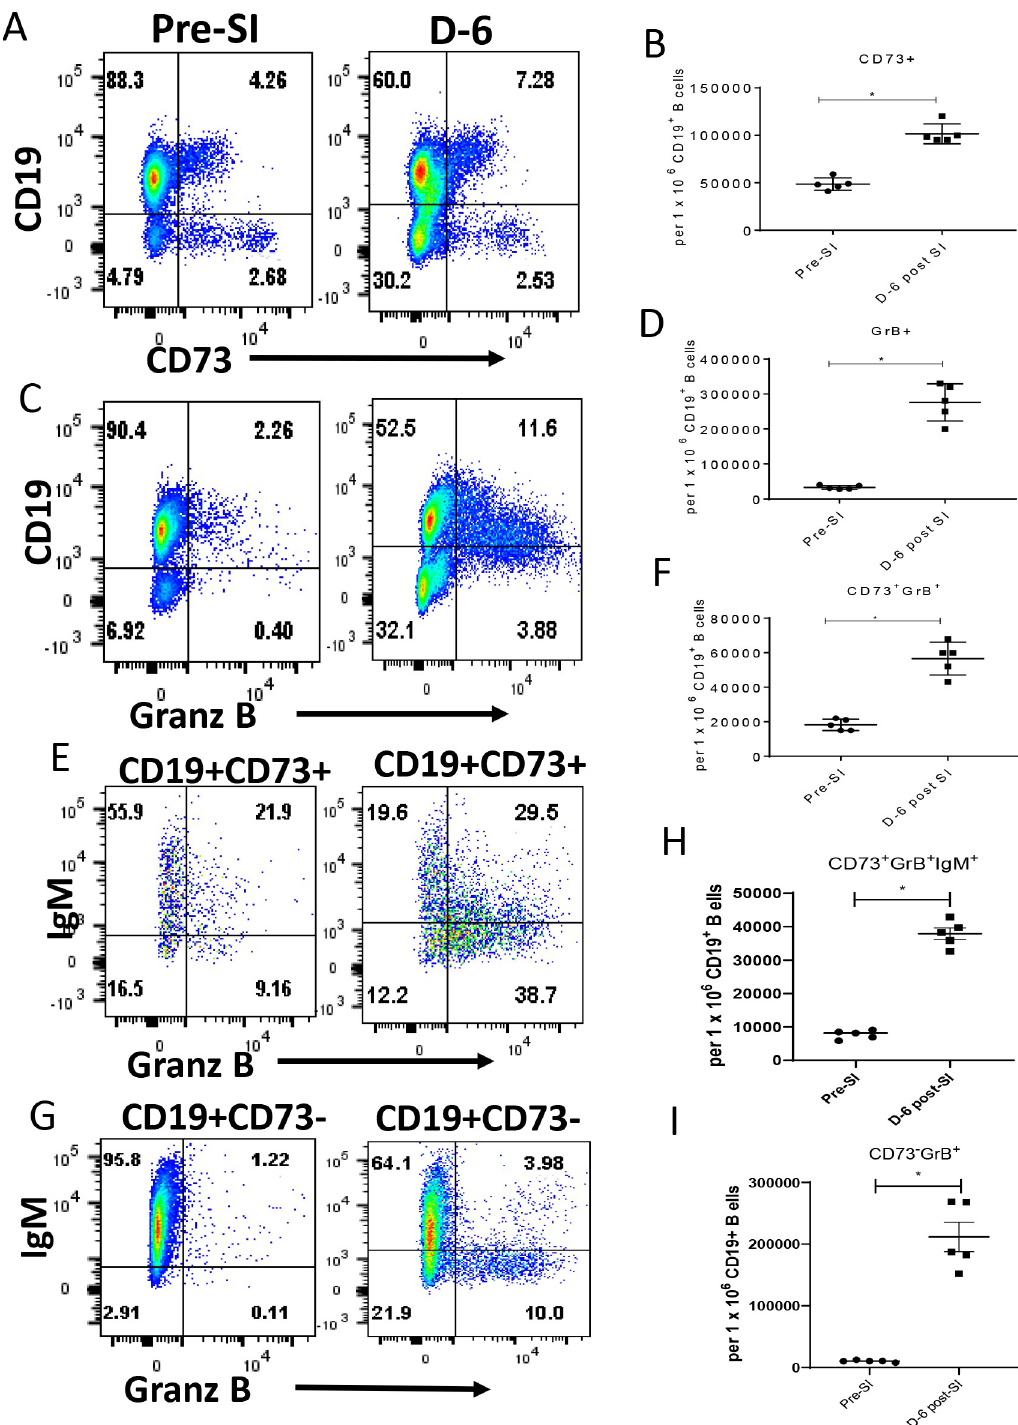
Fig 5. Comparison of CD19+ B cell frequencies expressing CD73 and GrB the day before and at Day 6 post-secondary infection with PyNL. Splenic B cells were recovered from PyNL immune mice two months post-primary PyNL infection (Pre- SI) or six days post-secondary PyNL infection (D-6 post-SI) (secondary infection at 2 months post-primary infection). Frequencies of CD19 + B cells expressing (A, B) CD73, (C, D) GrB, (E, F) CD73 and GrB, (E, H) CD73, GrB, and IgM markers or (G, I) CD19 + CD73 - , GrB + , IgM + cells were measured by flow cytometry at these time points. Representative dot plots (A, C, E, G) show frequencies of these different populations at Pre-SI and D-6 post-SI. Representative experiment of two experiments is shown. Mann-Whitney test was used for statistical evaluation. Mean ± SEM; � p < 0.05; n = 5 mice per group. https://doi.org/10.1371/journal.pone.0238493.g005 PLOS ONE | https://doi.org/10.1371/journal.pone.0238493 September 4,